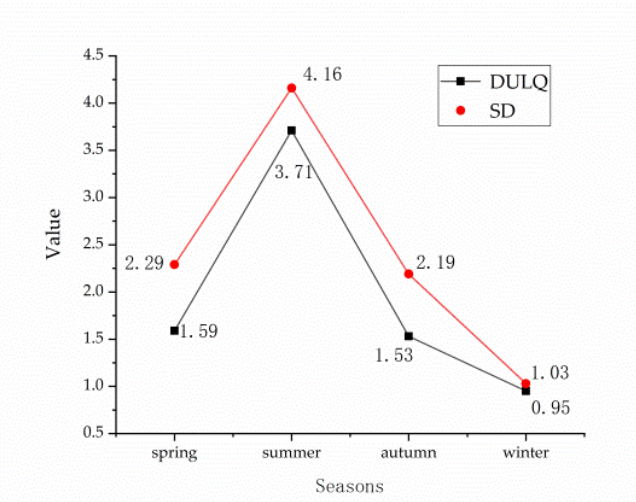
Figure 3. Seasonal LST’s standard deviation(SD) and difference between upper and lower